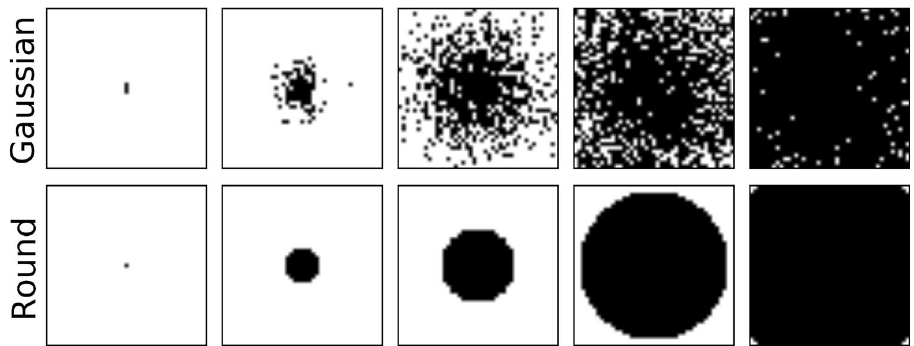
Figure 2. Two different methods to damage BiLex’s maps in order to simulate stroke damage. Black pixels represent SOM neurons that are removed (along with their associative connections) and white ones those that remain intact. Moving left to right, the amount of damage increases from almost zero to nearly total; adjusting the damage in this way, impairment in real patients can be matched.